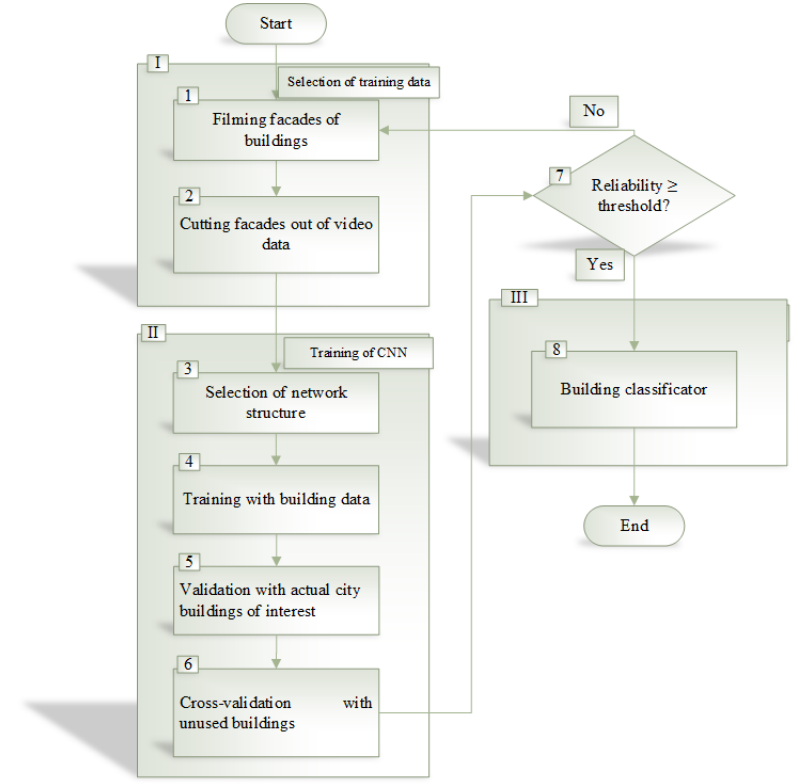
Figure 8. Deep learning-based methodology to identify building